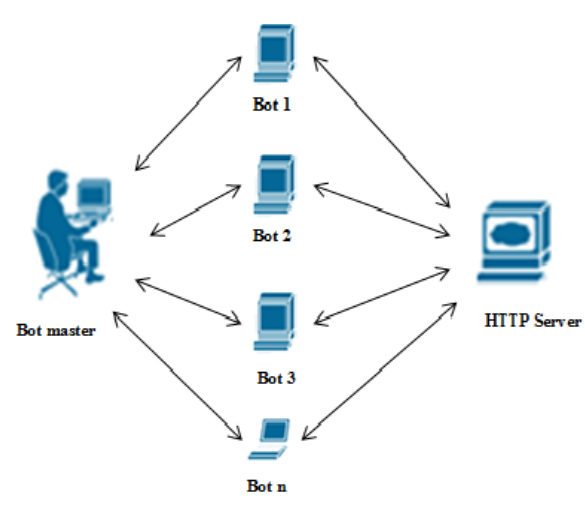
Figure 2. Mimicking attack creation